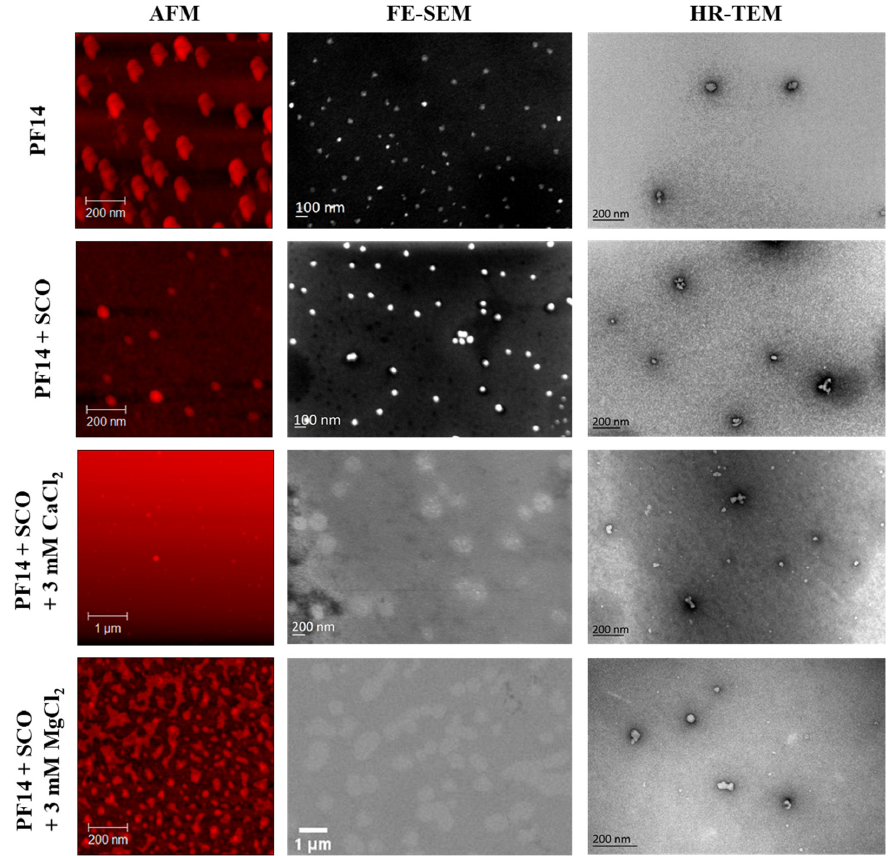
Figure 5. Morphology of particles formed by PF14 dissolved in EtOH90/DMSO9.6/TMC0.4 and its complexes with SCO and divalent metal ions added in the form of CaCl 2 and MgCl 2 . Nanoparticles were prepared by mixing SCO and PF14 at MR 10 and adding CaCl 2 and MgCl 2 after 15 min. After a total of 30 min of incubation, solutions were analysed by AFM, field emission SEM (FE-SEM), or high-resolution TEM (HR-TEM).